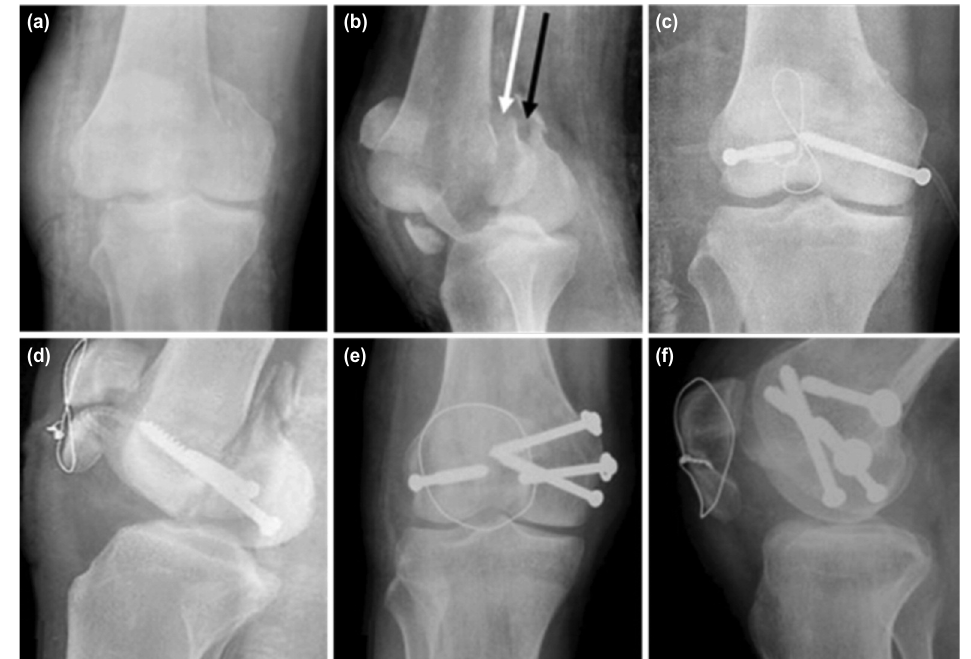
Radiographs at initial presentation, (a) Antero-posterior (AP) and (b) lateral view of the right knee showing the bicondylar Hoffa Fig. 1: fracture (black and white arrow point to the larger medial condyle and small lateral condyle fragment respectively). Radiographs following anatomical reduction and stable internal fixation with 3 partially threaded 6.5mm cancellous lag screws with 2 washers for the medial condyle and 1 lag screw for the lateral condyle combined with a patella cerclage wire. Immediate